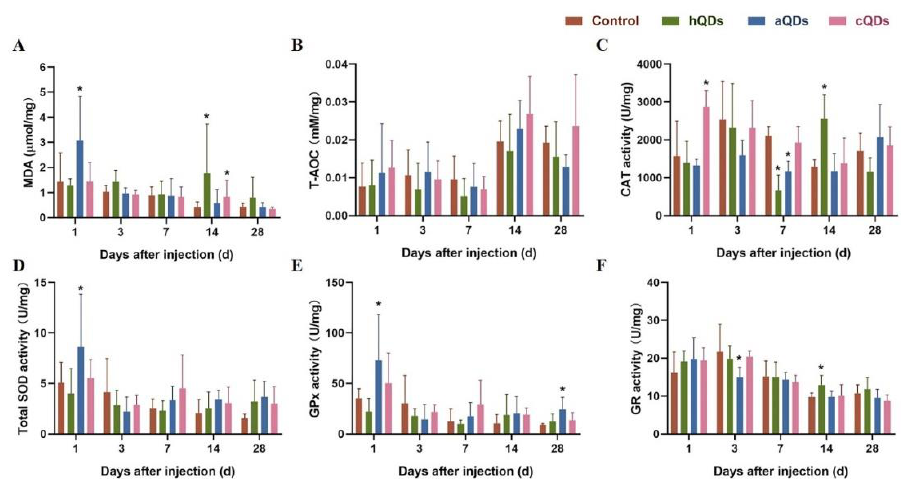
Figure 7. Oxidative stress levels in kidney tissues from QDs-treated mice at different predetermined time points after being administered with 25 mg / kg BW QDs. ( A ) MDA levels. ( B ) T-AOC levels. ( C ) CAT activities. ( D ) Total SOD activities. ( E ) GPx activities. ( F ) GR activities. (* Significantly different compared to control group, p < 0.05).